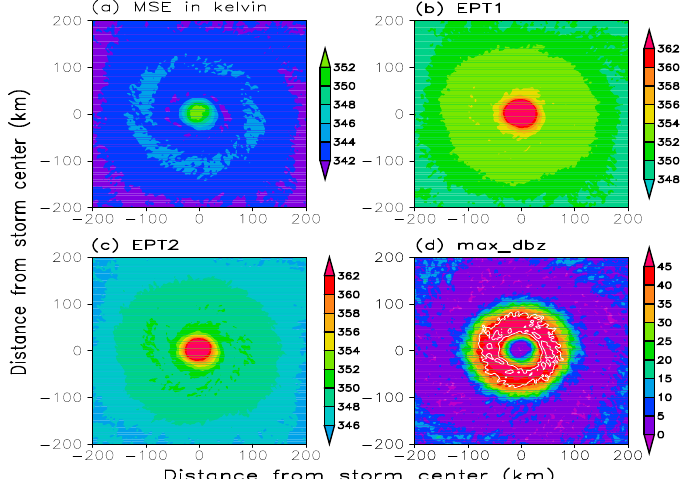
Figure 4. Plan views of temporally averaged boundary-layer ( a ) MSE normalized by c p (K), ( b ) equivalent potential temperature (K) defined by Bolton [35], ( c ) equivalent potential temperature (K) defined by Rotunno and Emanuel [36], and ( d ) temporal mean simulated maximum radar reflectivity (dBZ) between 108 h and 120 h. Vertical averaging for ( a – c ) is taken over the lowest 1 km. The cold pool of MSE with values smaller than 343 K is also superimposed on ( d ) by white lines at intervals of 1 K.